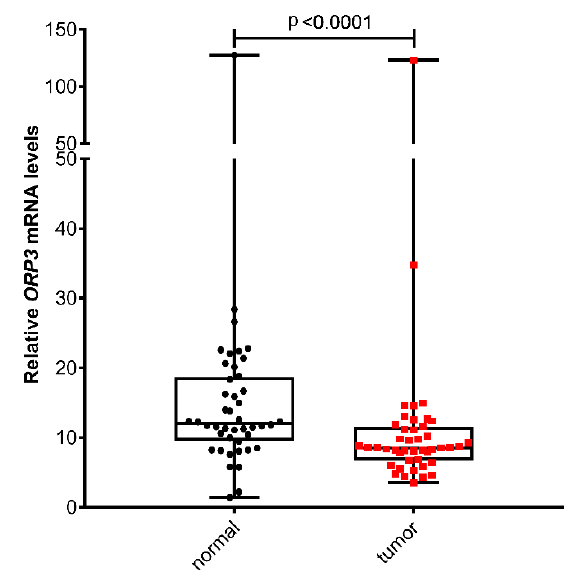
Figure 1. ORP3 mRNA levels are downregulated in the tumor tissue of human colorectal cancer (CRC) patients. ORP3 mRNA levels were determined in samples derived from matched normal and tumor tissues of the same patients in a cohort of 44 patients. Box plot analysis show the group comparison of relative ORP3 RNA expression in normal and tumor tissues of CRC patients. (Wilcoxon test). Black dots represent normal tissue samples and red dots represent tumor tissue samples.